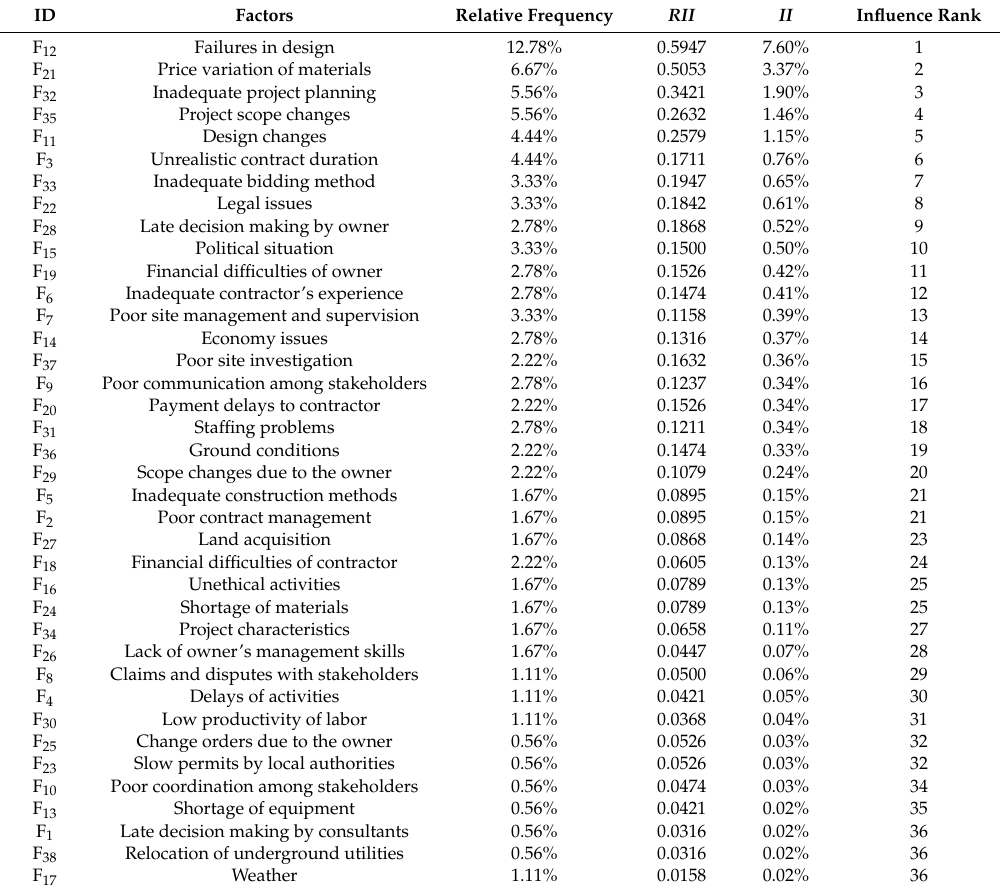
Table 7. Top cost overrun factors according to the Influence Index ( II